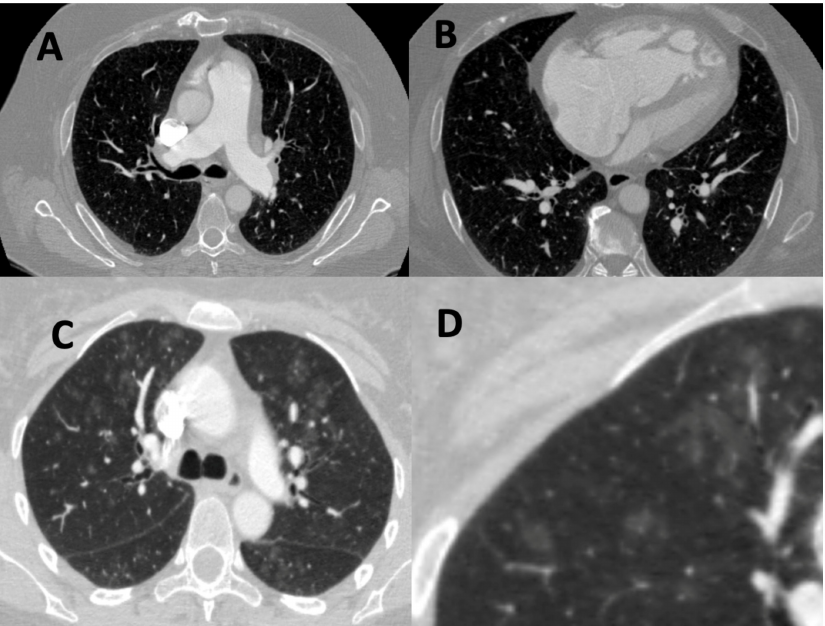
Figure 2. Computed tomography (CT) features of pulmonary arterial hypertension (PAH) on CT. ( A ) Dilated main pulmonary artery. ( B ) Right atrial and ventricular dilation with moderate right ventricular hypertrophy and flattening of the interventricular septum. ( C ) Centrilobular ground glass nodularity. These are a feature of PAH but are also more commonly seen in another sub-phenotypes of pulmonary hypertension, such as pulmonary vascular obstructive disease (PVOD). In PVOD, they are often accompanied by interlobular septal thickening and mediastinal lymphadenopathy. ( D ) Zoomed in view of regions of centrilobular ground glass nodularity.